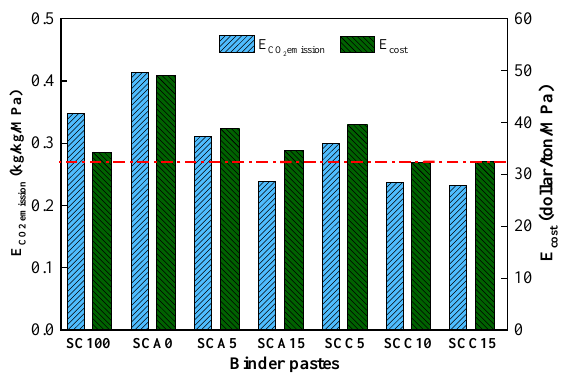
Figure 15. Normalized CO 2 emission and cost of binder pastes.